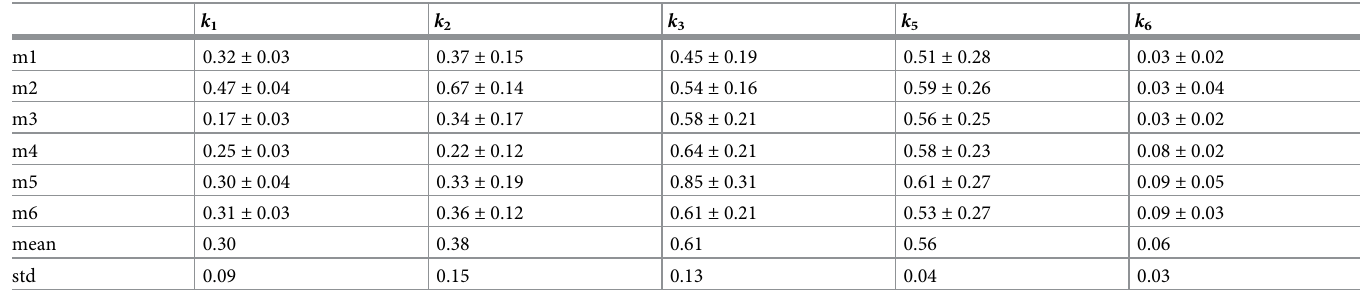
Table 2. Reconstructed kinetic parameters (1/min) of BCM.